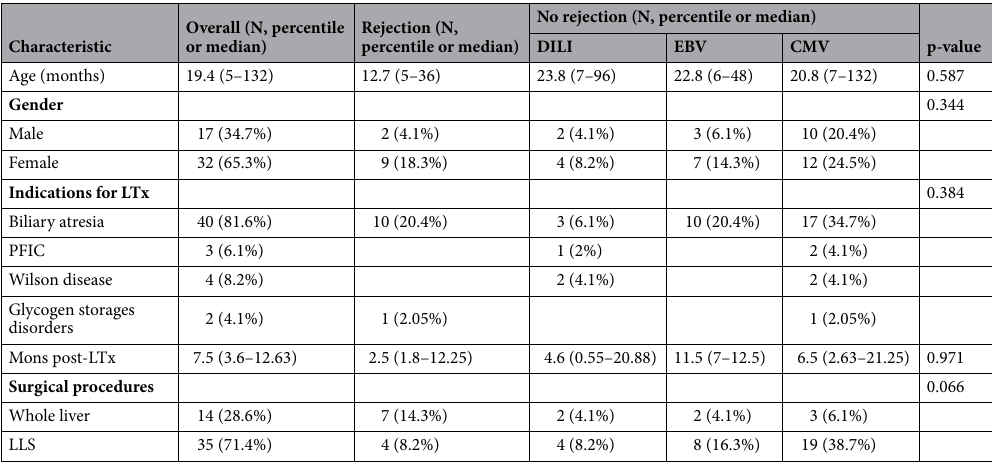
Table 1. Demographics and baseline characteristics. DILI drug-induced liver injury, EBV Epstein–Barr virus, CMV cytomegalovirus, PFIC progressive familial intrahepatic cholestasis, LLS left lateral